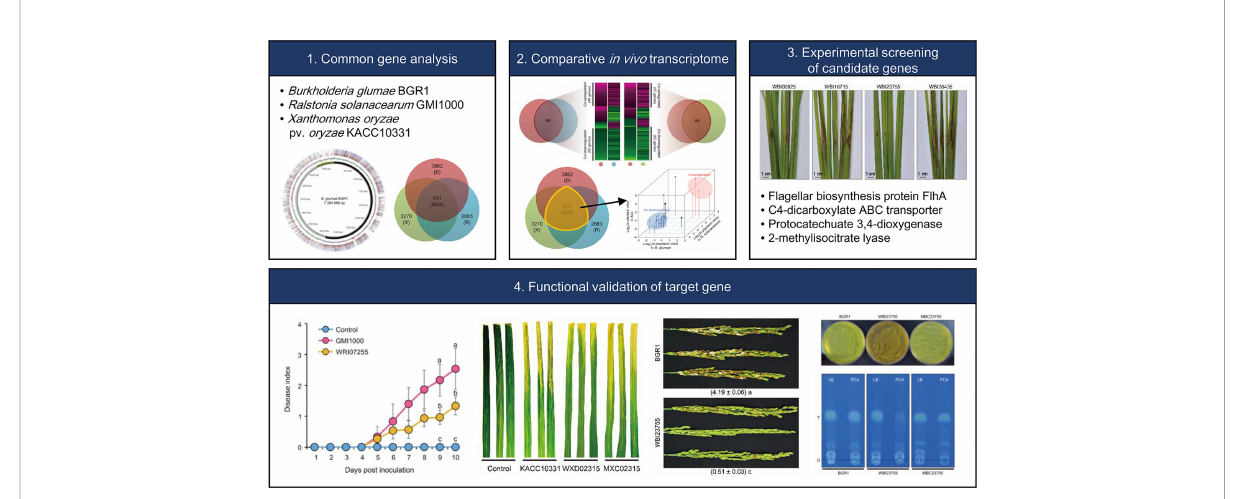
FIGURE 7 Schematic diagram representing the work fl ow adopted in this study to identify common cross-species virulence factor of phytopathogenic